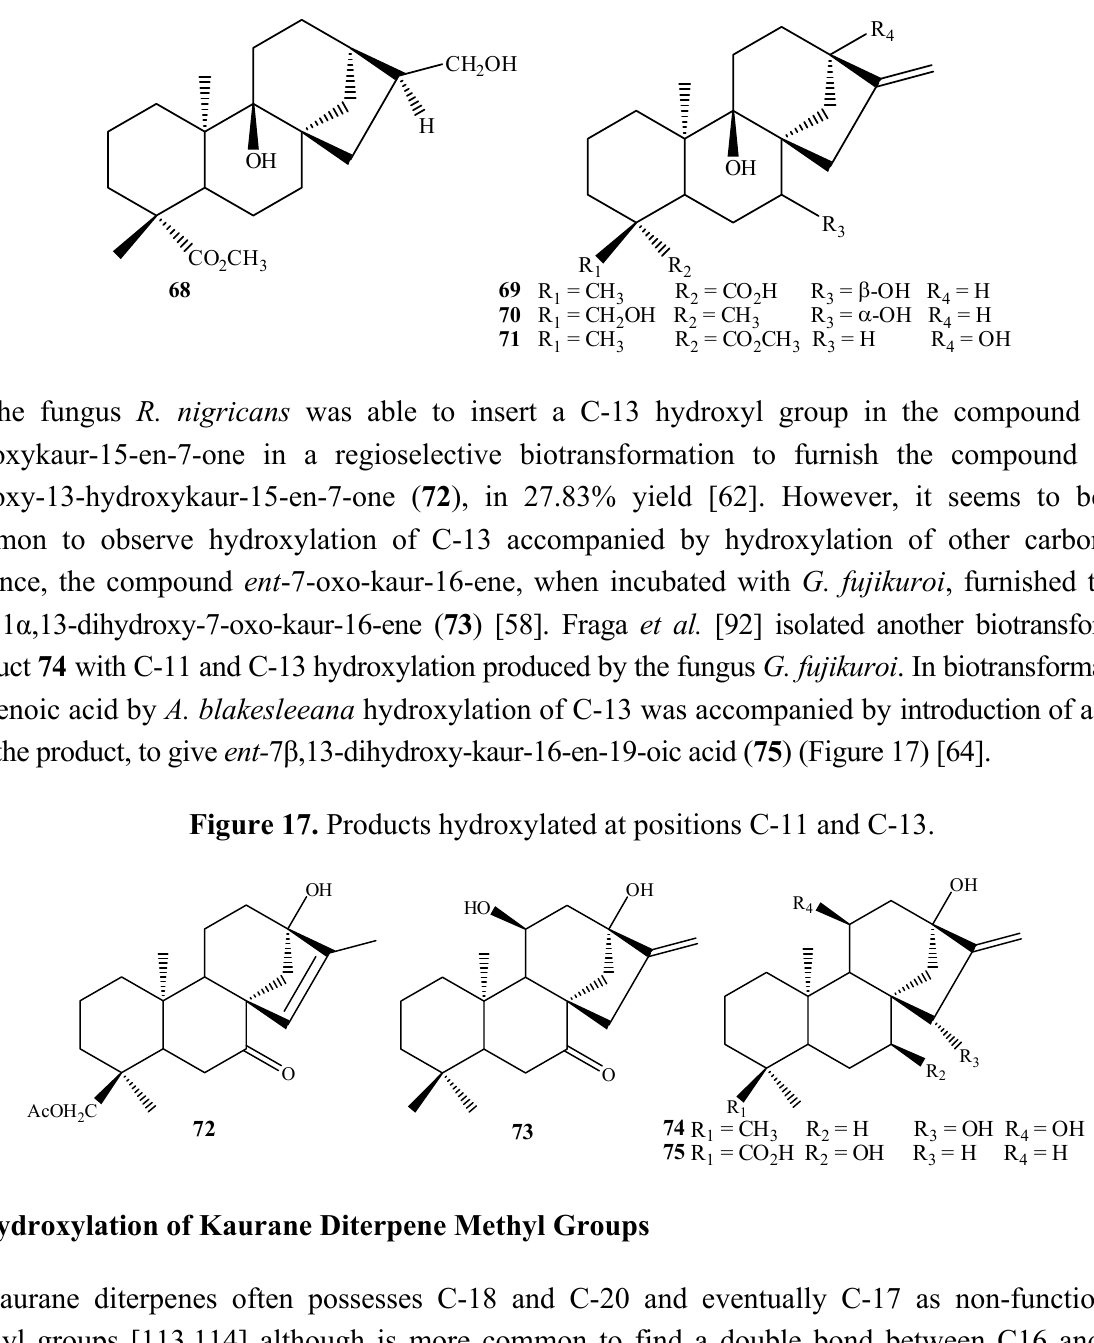
Figure 16. Chemical structures of some biotransformation products hydroxylated at C-9.